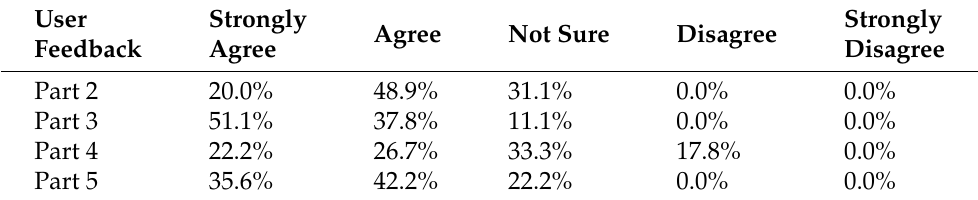
Table 7. Summarized results of the